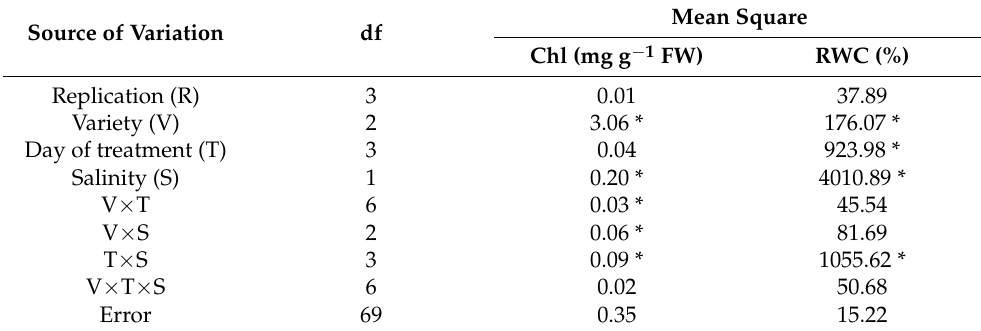
Table 5. ANOVA result of chlorophyll and relative water content.